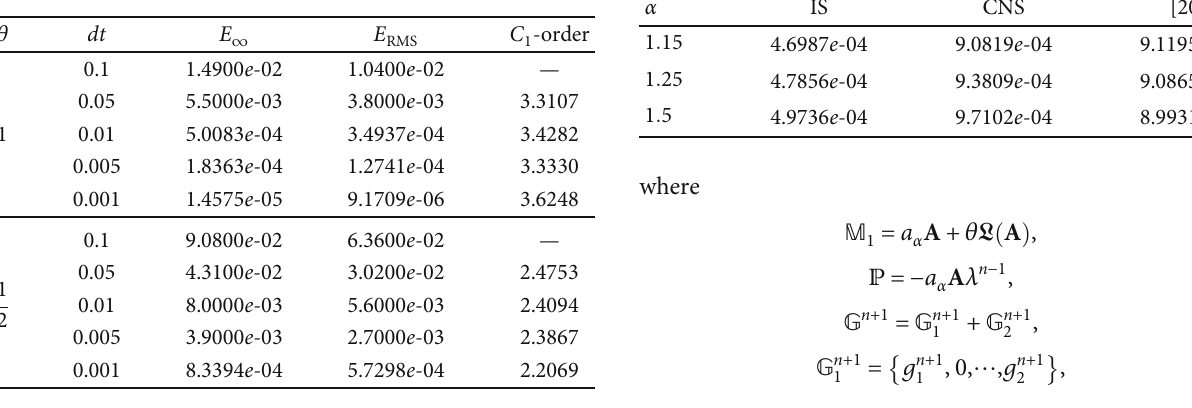
Figure 7: Approximate solution at di ff erent time levels by using (a) IS and (b) CNS for the Problem 3. Table 6: Error norms and computational order for di ff erent time steps for N = 50, c = 8 : 1 and t = 1 for the Problem 3.